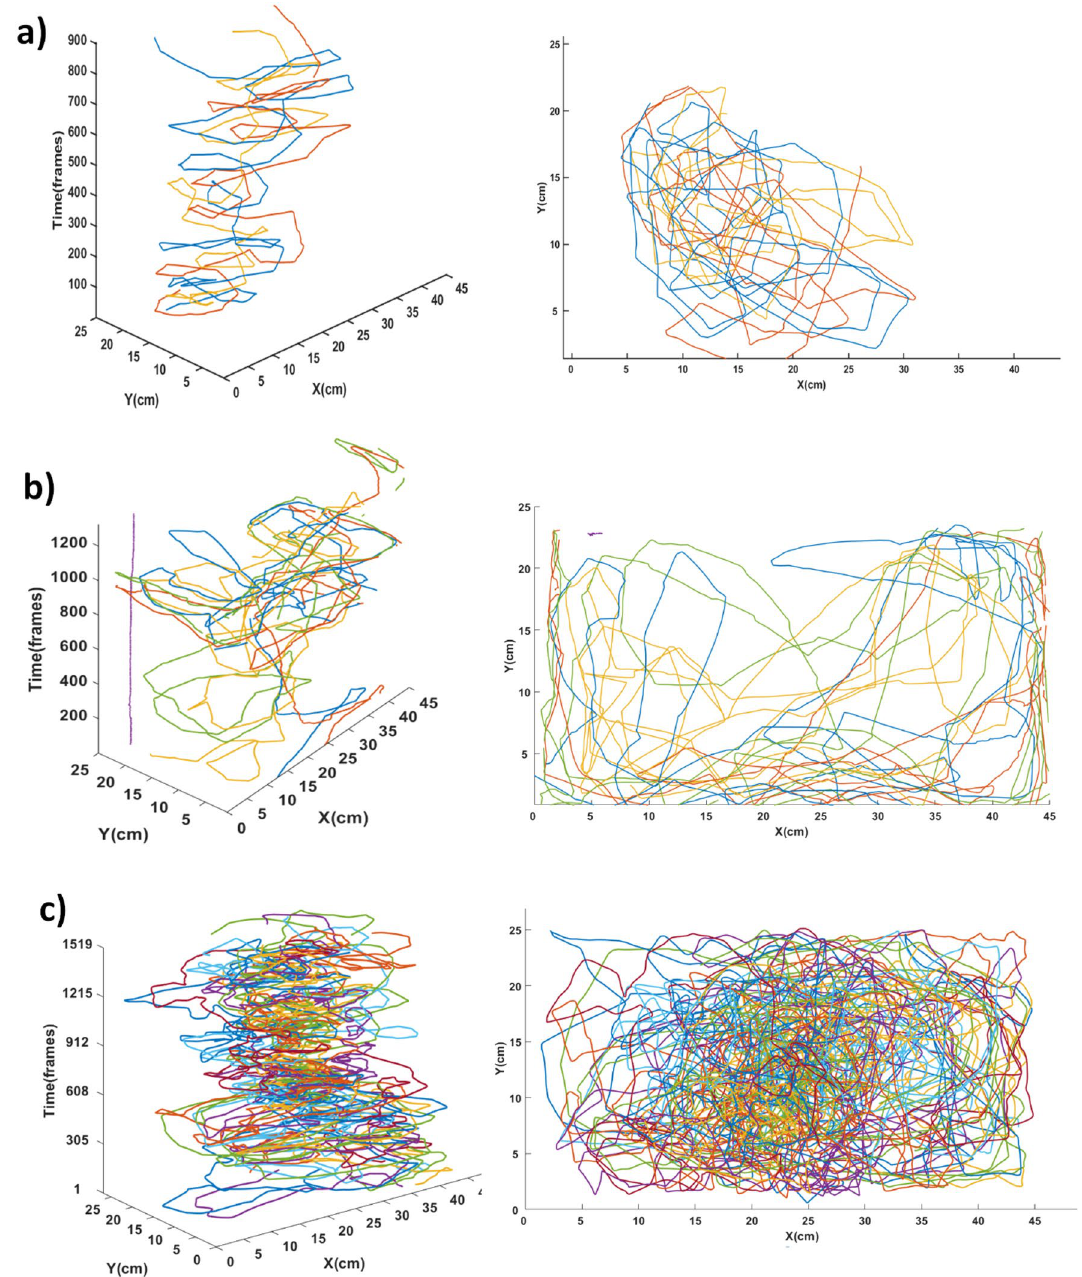
Figure 8. Result of tracking different groups of fish. (a) Tracking of group D1 with 3 fish and (b) group D2 with 6 fish, both in a state of slow motions, (c) group D6_food with 13 fish are in the feeding period (fast motions). The fish swim with greater agitation and agglomeration in the center of the aquarium, a space where the food was